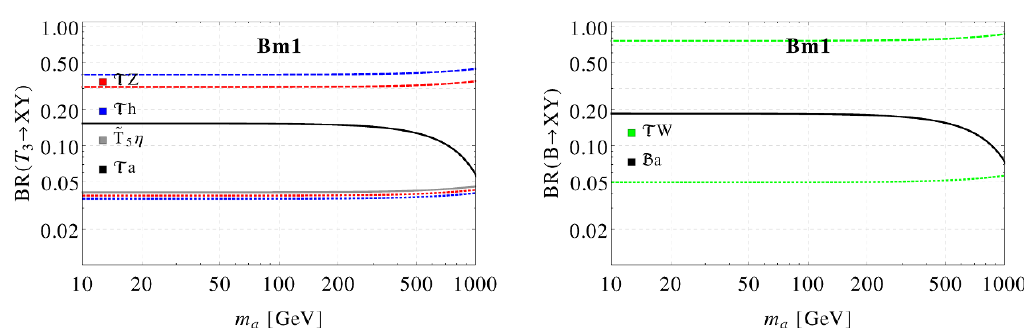
Figure 6 . Branching ratios for heavier VLQs as a function of the mass m a in the benchmark model Bm1 de(cid:12)ned in eqs. (3.14) and (3.15). The continuous, dashed and dotted lines correspond respectively to T = f t; T 1 ; T 2 g or B = f b; B g